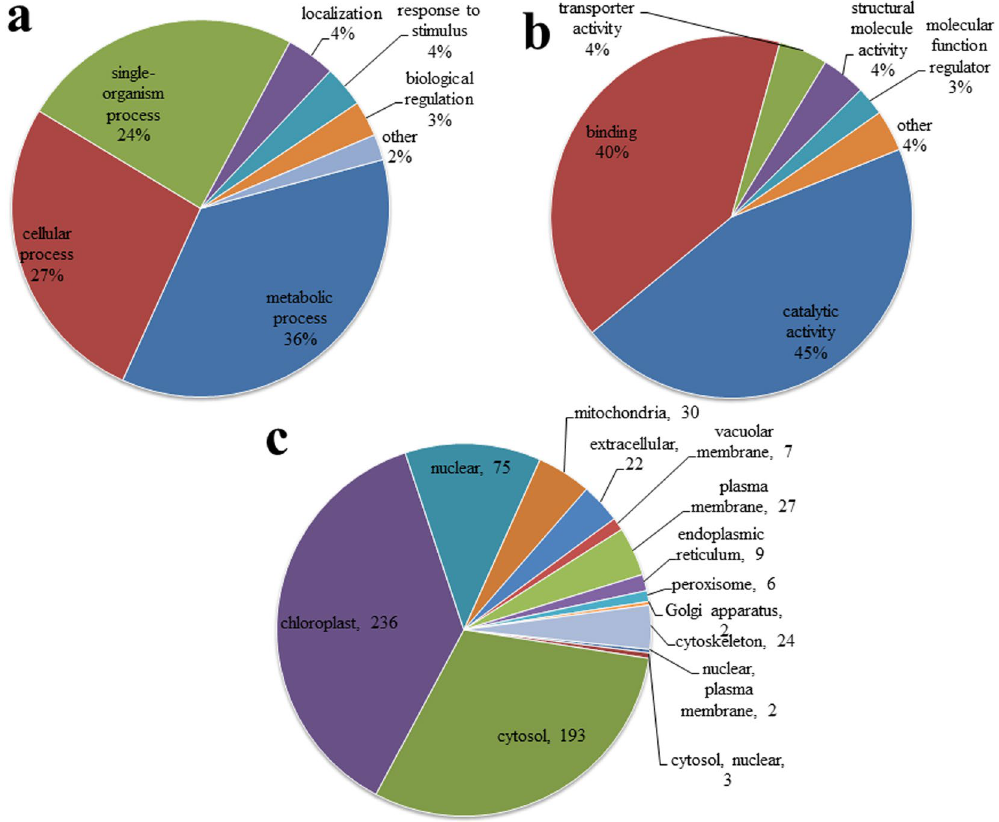
Figure 3. GO classification of the crotonylated proteins based on biology process ( a ) molecular functional ( b ) and subcellular localization ( c ),